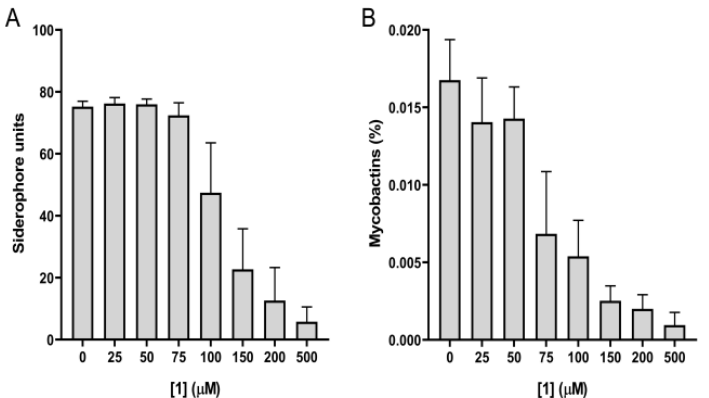
Figure 4. Compound 1 inhibits the production of siderophores and mycobactins by M. bovis BCG in iron-limiting conditions. ( A ) Siderophore units in culture media of cells grown in the presence of different concentrations of 1 , determined by the Universal CAS assay. ( B ) Determination of mycobactins extracted and measured in the above-mentioned cells. Data are mean ± SD of three replicates.